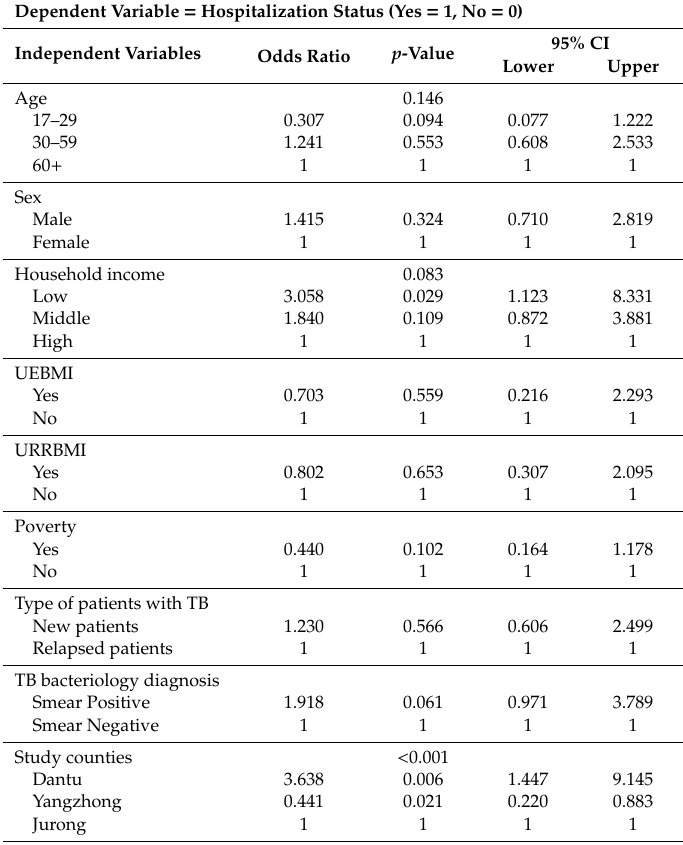
Table 4. Factors associated with hospital admission rates of patients with TB in Zhenjiang,